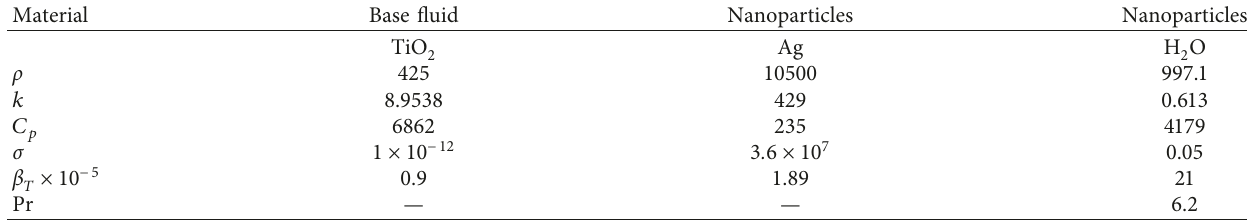
Table 1: Nanoparticles and base fluid thermophysical characteristics [37].